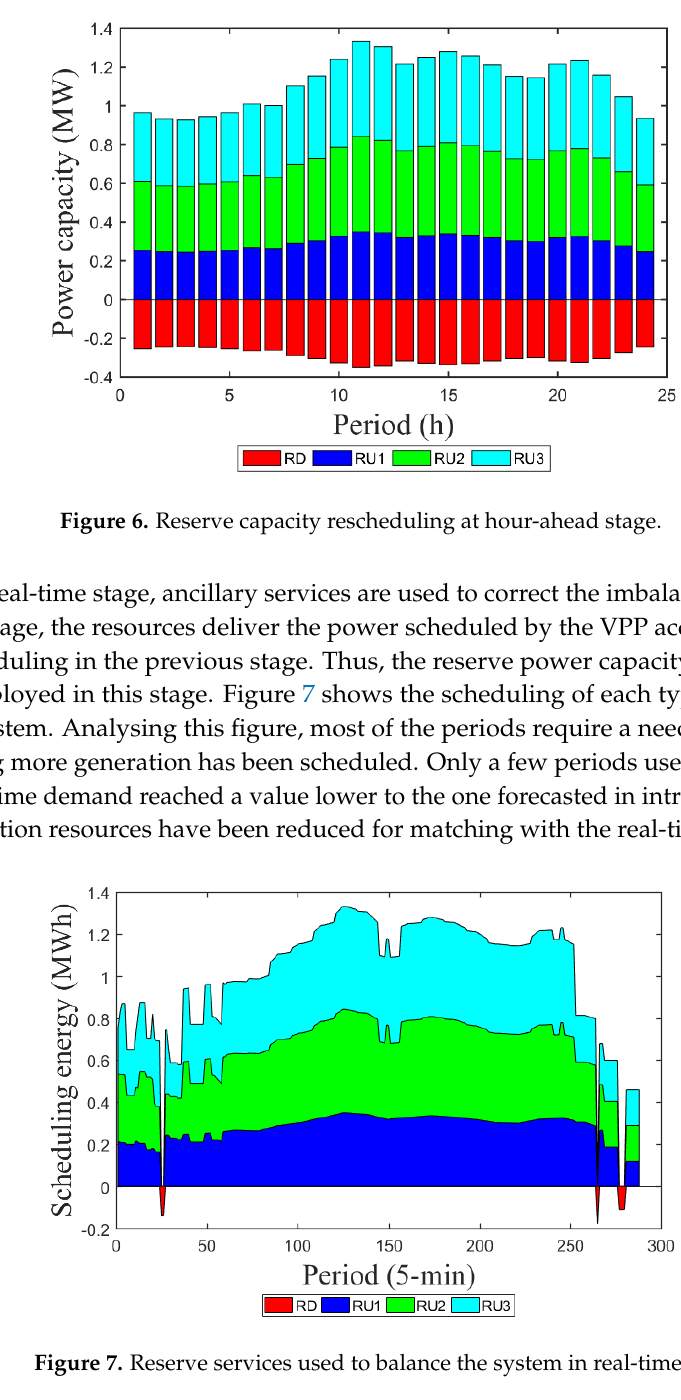
Figure 5. Reserve capacity scheduling at day-ahead stage.